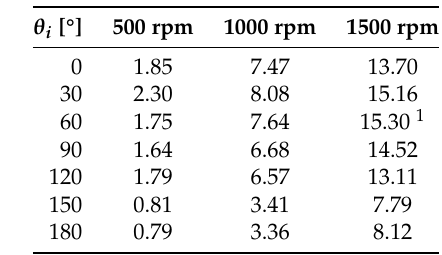
Table A1. Data steering-grid thruster D g ( n g , θ i )